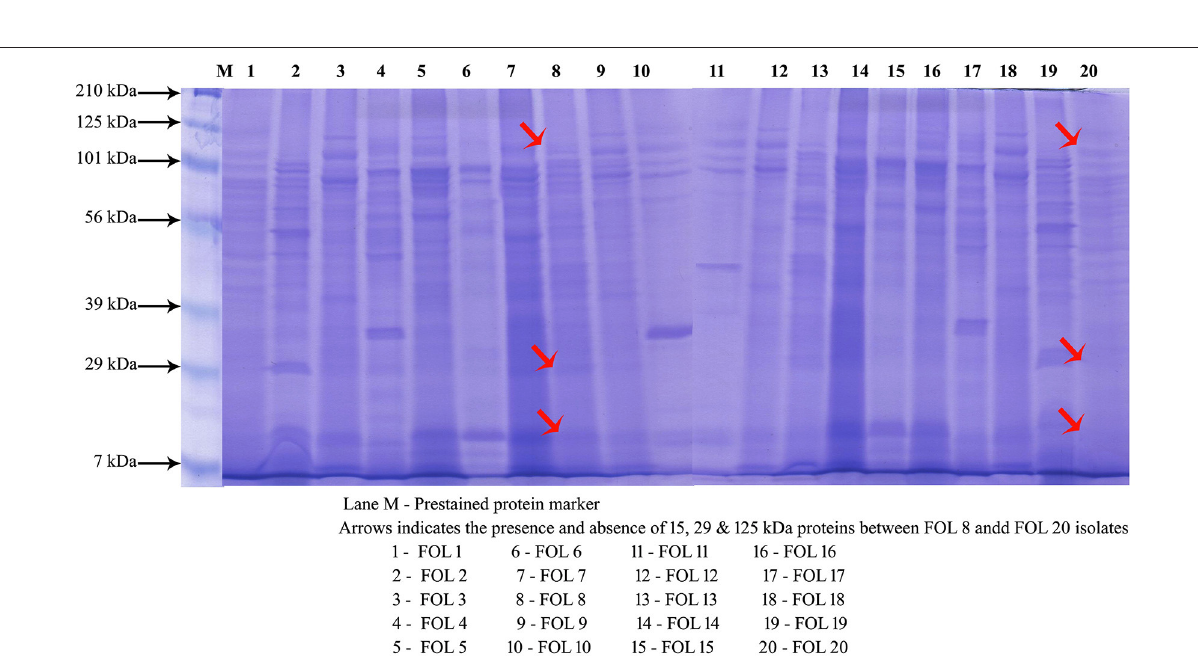
functions of identified proteins were assigned by comparing their sequences to public protein database NCBInr. The identified proteins were Chaperone (gi|389744937), FAD binding domain containing protein (gi|347838696), Sulfate anion transporter (gi|471900325), Cytochrome P450 (gi|407916132), Cutinase- 2 (gi|302408527), Glycoside hydrolase family 85 protein (gi|451995113), ATP-dependent RNA helicase (gi|402072144), 60S ribosomal protein (gi|615462440), and two were hypothetical proteins (gi|587722065 and gi|591452081). All identified